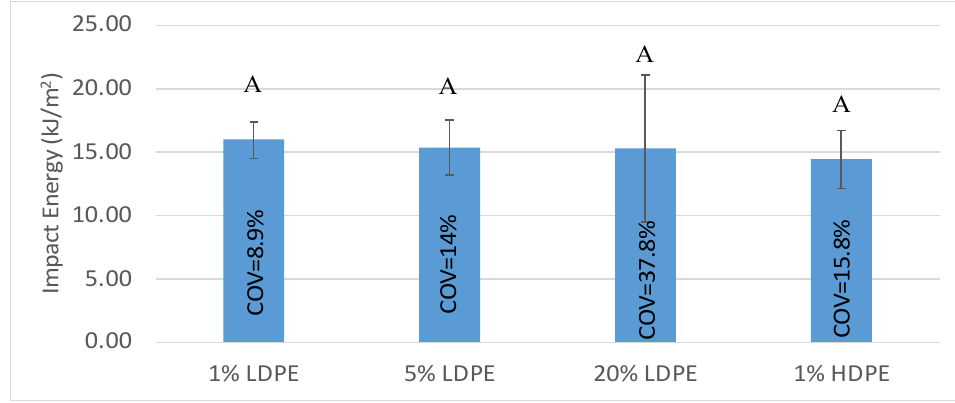
Figure 8. Izod impact energy test results of RTM panels (PE types with the same letter above the bar indicate that their means were not statistically significant).